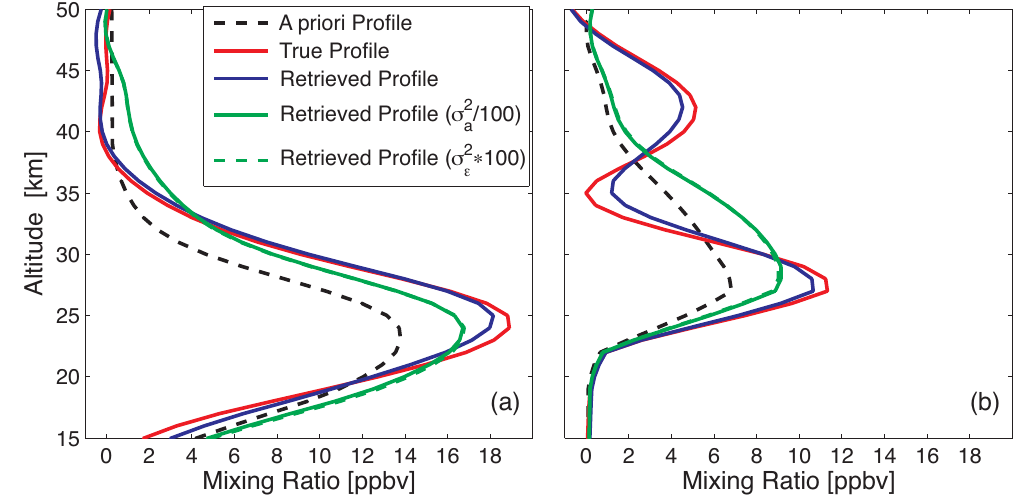
Fig. 2. Profile retrievals of HNO 3 synthetic spectra forward-simulated starting from two typical HNO 3 distributions that could be observed at polar regions during late fall (a) and winter (b) . Retrieved results obtained using selected σ 2 ε and σ 2 a values are shown (blue line) together with a priori profiles (dashed black line) and “true” synthetic vertical profiles (red line). Retrieval results obtained increasing σ 2 ε by a factor 100 (dashed green line) and decreasing σ 2 a of the same factor (solid green line) are also